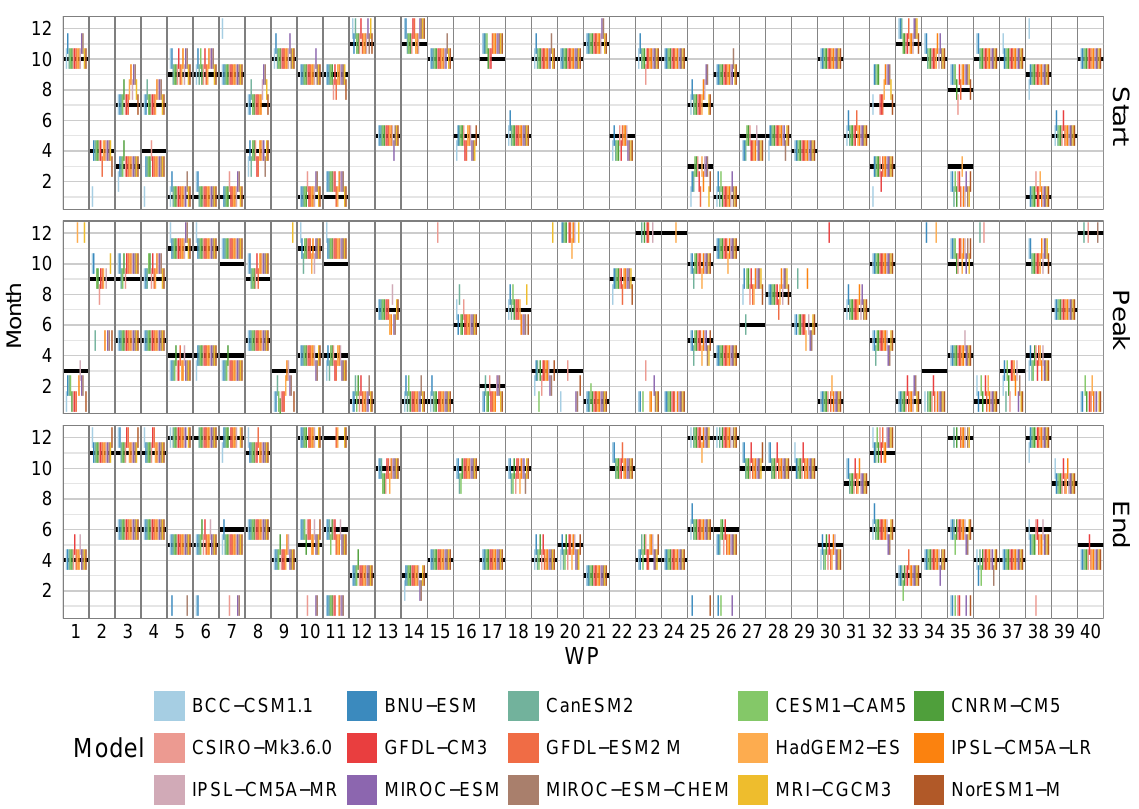
Figure 9. Comparison of seasonality of patterns in GCMs (coloured vertical dashes) and reanalysis data (black horizontal dashes). Seasonality is presented as start month(s) (upper panel), peak month(s) (middle panel), and end month(s) (lower panel) of occurrence of patterns. Dashes for GCMs are only vertical to avoid overlapping – each symbol denotes 1 distinct month. If a pattern occurs in two distinct seasons, both are